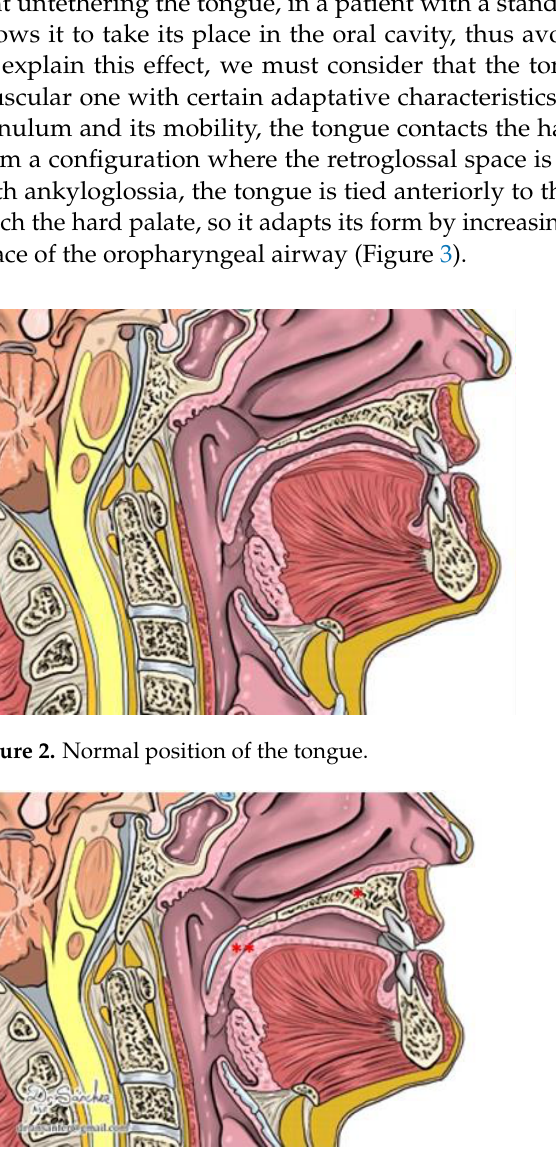
Figure 3. Ankyloglossia: The tongue is not in contact with the hard palate (*) and is invading the retroglossal space (**).